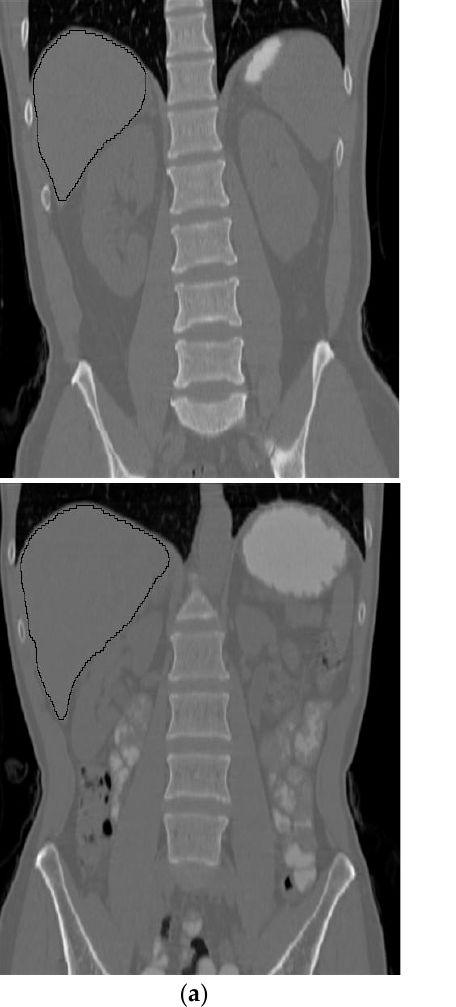
Figure 11. Two samples of the results of the liver segmentation method. ( a ) Front view, ( b ) side view.